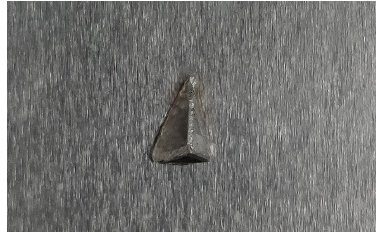
Figure 2. Pyramid attached to the falling film surface as an example of a film disturbance. Table 1. Experimental plant dimensions.